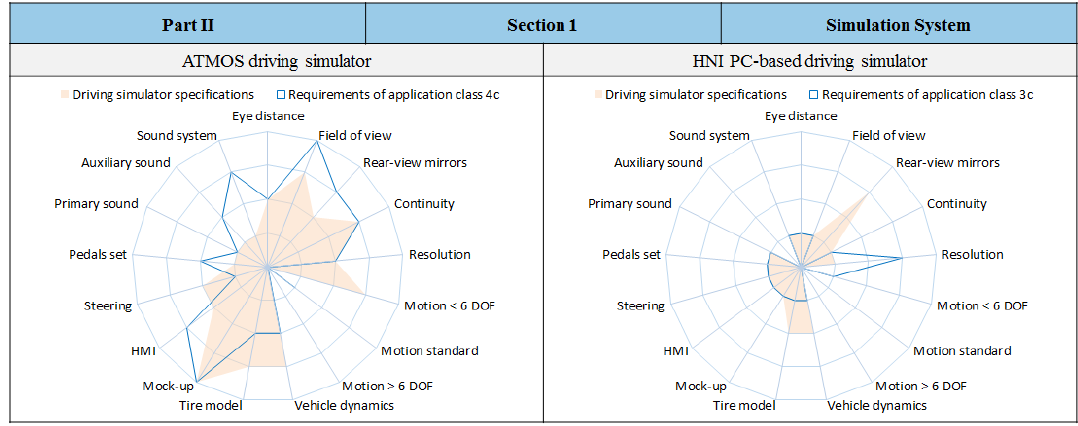
Figure 13. Specification/requirement radar charts of the selected system components.